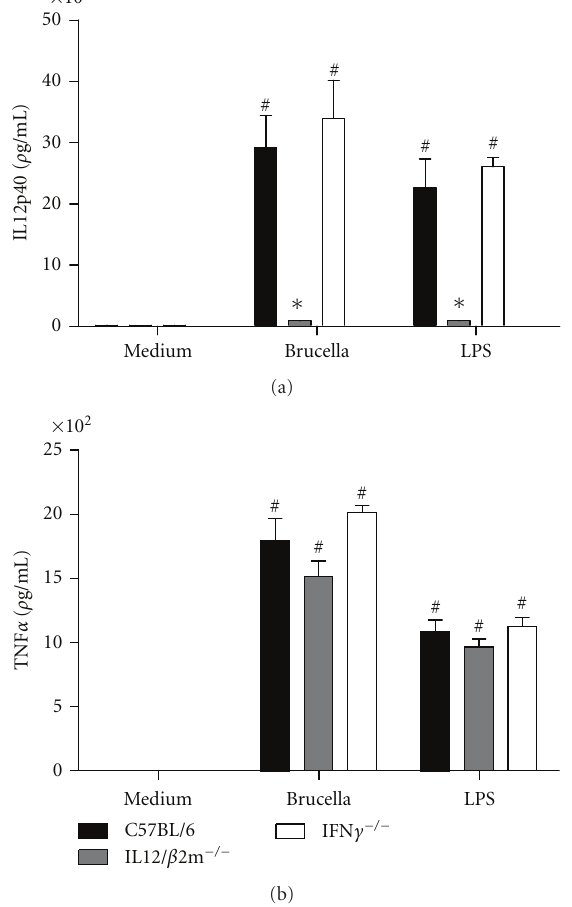
Figure 4: IL-12 and TNF- α production induced by B. abortus in IFN- γ KO or IL-12/ β 2-m KO macrophages. Bone marrow from C57BL/6, IFN- γ − / − , and IL-12/ β 2-m − / − mouse cells were di ff erentiated in macrophages and stimulated with B. abortus S2308 (MOI 100 :1) or E. coli LPS (1 μ g/mL). Supernatants were harvested for measuring IL-12 (a) and TNF- α (b) after 24hrs by ELISA. Significant di ff erence in relation to nonstimulated cells is denoted by the symbol # and an in relation to C57BL/6 mice is denoted by an asterisk ( P < 0.05). Results are means ± standard deviations of experiments performed with three animals. Data shown are representative of two di ff erent experiments.